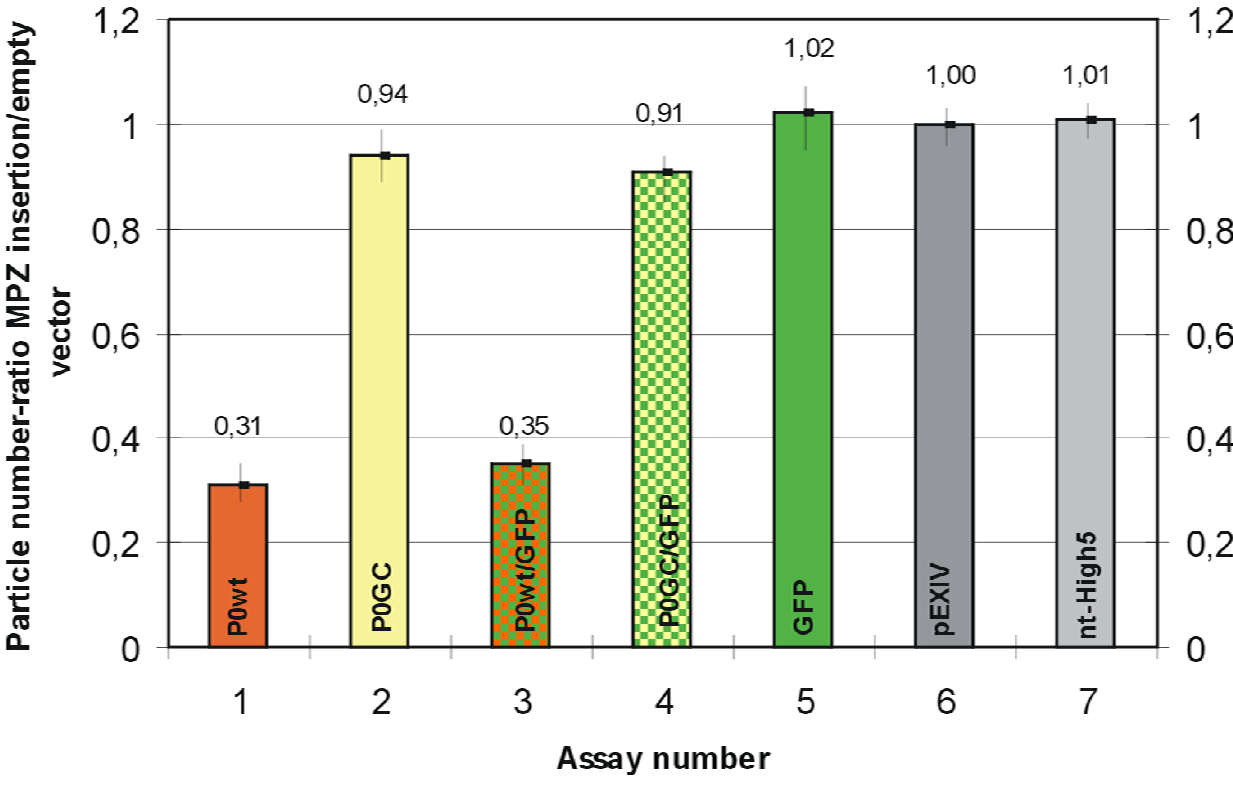
Figure 9 Adhesion assay with High5 cells transfected with wild type P0, mutated P0 (Ala221fs), wild type P0-GFP and mutated P0-GFP. Adhesion is seen with wild type P0 (indicated in the figure as P0wt) with and without GFP fusion. The neg- ative controls, GFP alone, empty vector and non-transfected cells, as well as the Ala221fs mutation (indicated in the figure as P0GC) do not show